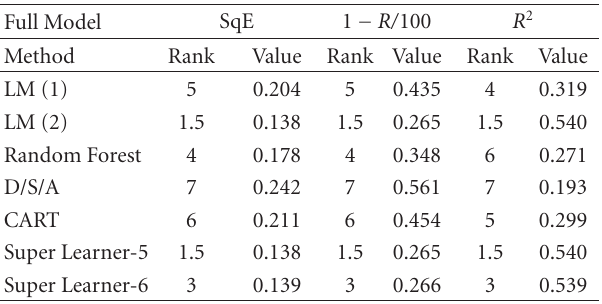
Table 3: Squared Error, R , R 2 and corresponding rank on Jaguar Trial